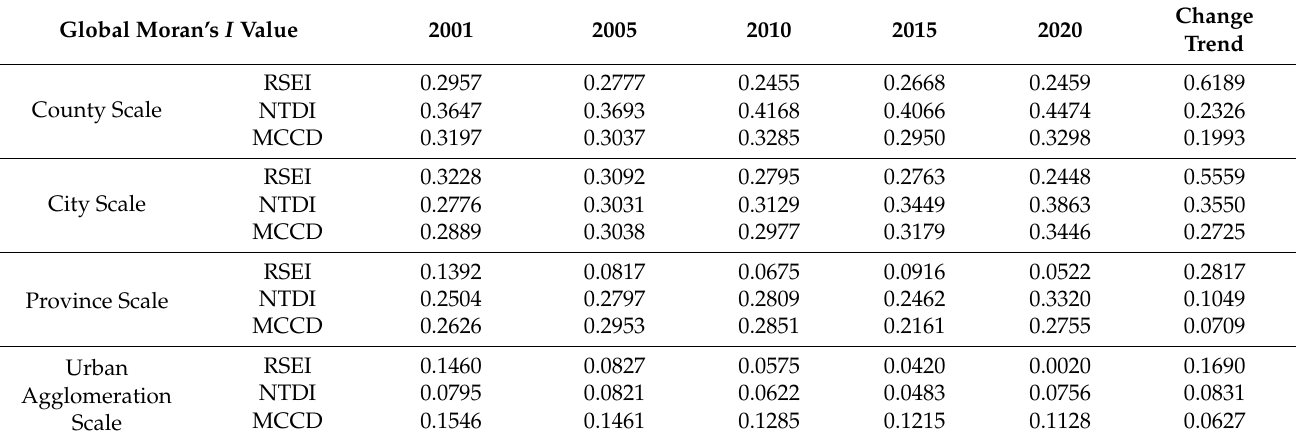
Table 2. Global Moran’s I value at different scales.